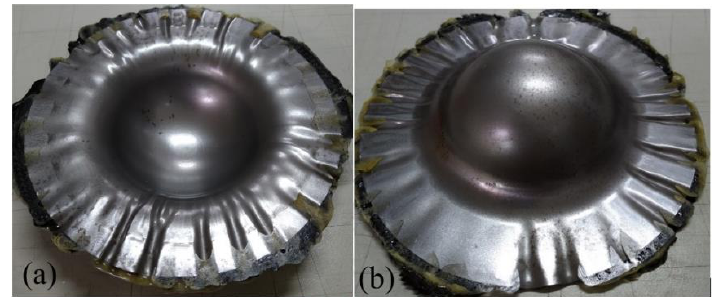
Figure 13. Deep drawing of steel-composite sandwich with blank-holding pressure of 0.6 MPa: ( a ) front view, ( b ) back view.